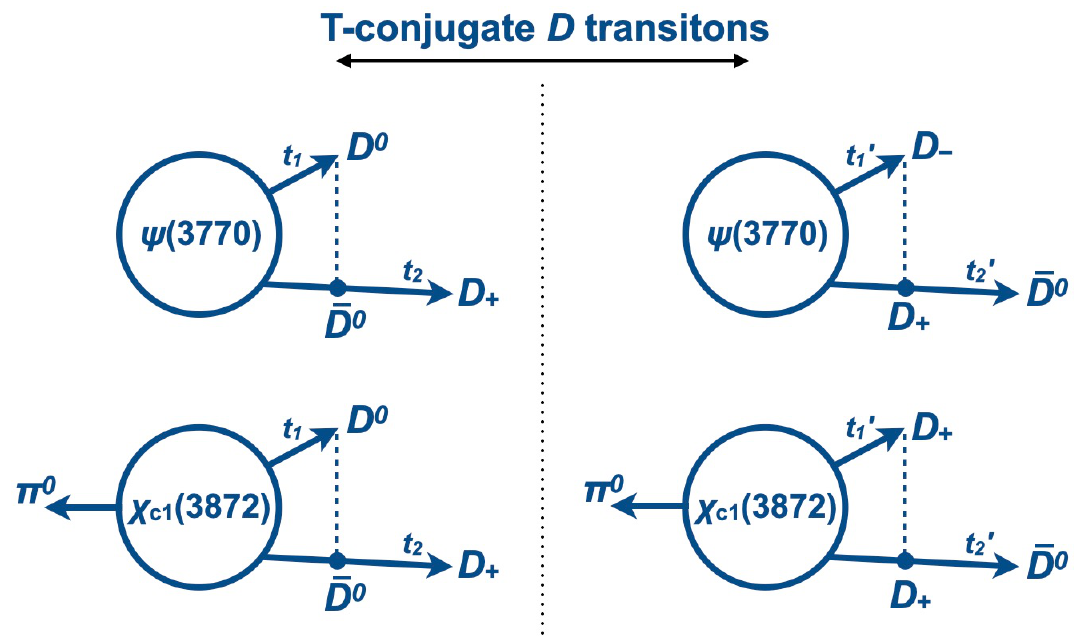
Figure 4. Examples of T -conjugate decay processes involving transitions between D eigenstates of flavor and D eigenstates of CP . Table 4 lists other symmetry-conjugate decay processes of interest, involving different